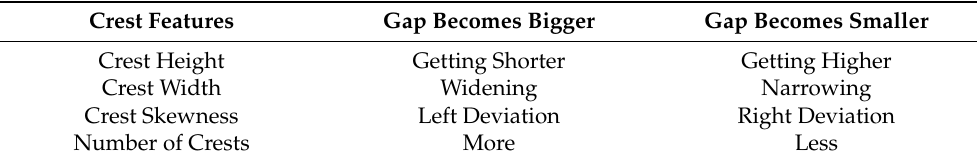
Table 1. Corresponding relationship between the distribution of the kernel density function and the gap level. Crest